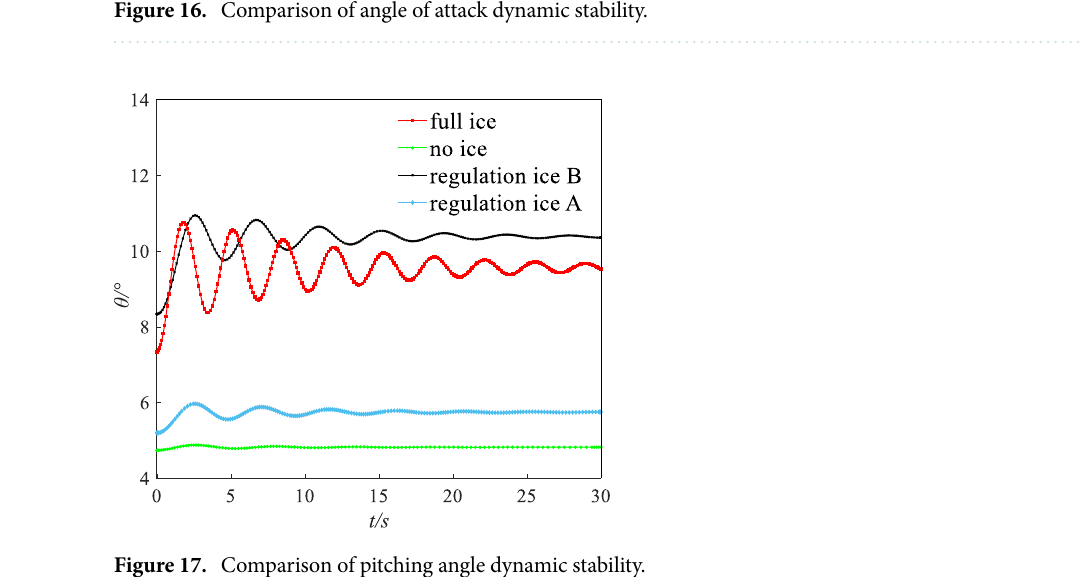
Figure 16. Comparison of angle of attack dynamic stability.